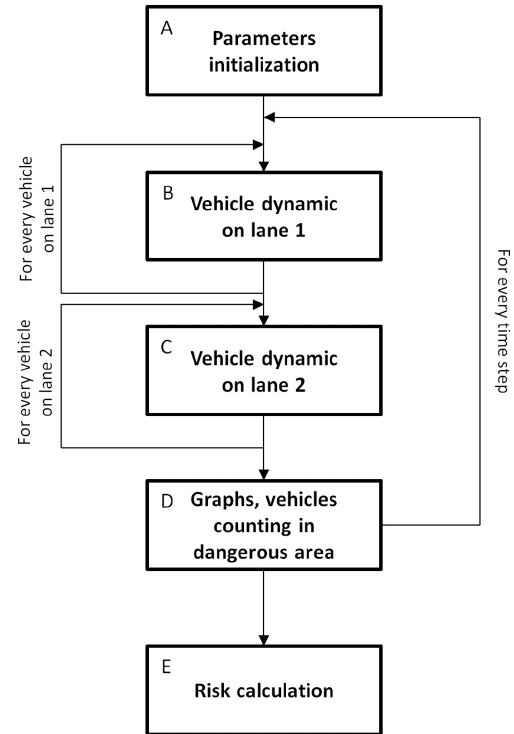
Fig. 1. Structure of the traffic simulator model. Box A is read once to initialize the parameters and the first vehicle on the road. Boxes B and C belong to the temporal loop which increments time every time step. During one time unit (1s), all the vehicles’ positions on lane 1 (box B) and on lane 2 (box C) are calculated. Finally, after the traffic simulation, different factors related to the risk calculation are computed in boxes D and